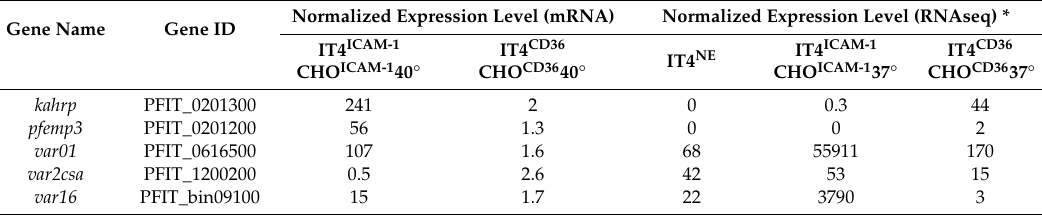
Table3. NormalizedexpressionlevelofvariousgenesofIT4 ICAM-1 CHO ICAM-1 40 ◦ , IT4 CD36 CHO CD36 40 ◦ compared to IT4 NE. determined using qPCR. For read counts (RNAseq) of IT4 NE , IT4 NE